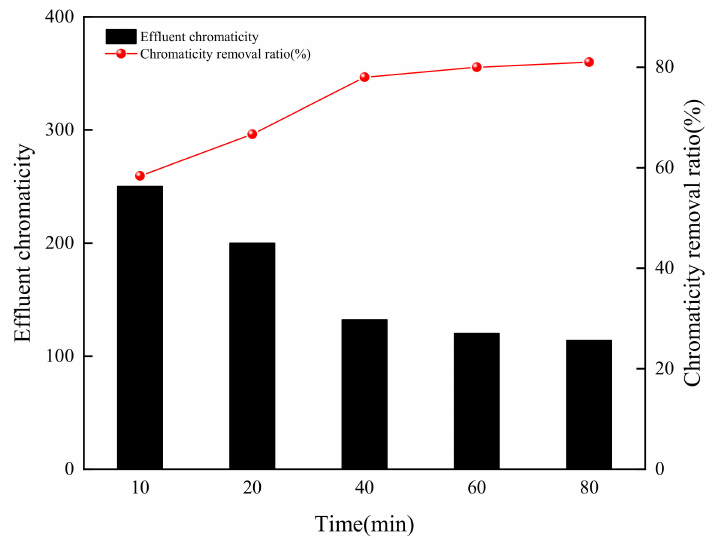
Figure 7. Effect of ozonation time on chromaticity removal (pH value =